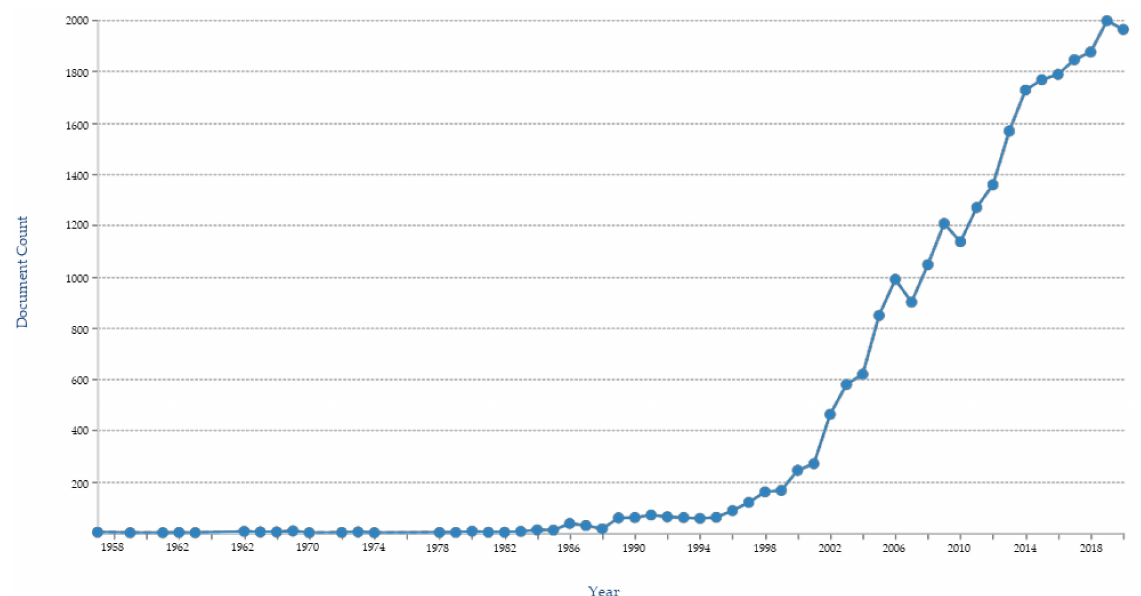
Figure 9. Year wise patent publications filed on podophyllotoxin.